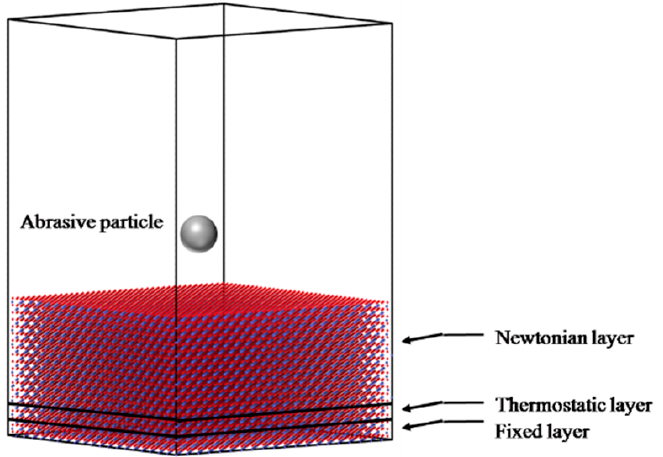
Figure 4. Schematic diagram of molecular dynamics model. Figure 5 shows the change of load with displacement when the abrasive particles approach the substrate surface at a moving speed of 2 Å/ps. The applied load shows several drops in the figure. The first load drop is located at the displacement of 9.3~9.9 Å, which is also known as the ejection effect, which is related to the initial plasticity of the base material. The second load drop is located at the displacement of 11.7~12.3 Å, which is attributed to the maximization of the amorphous layer. The third load drop is at 16.2~18.3 Å, which may be due to the sudden increase of distortion layer.